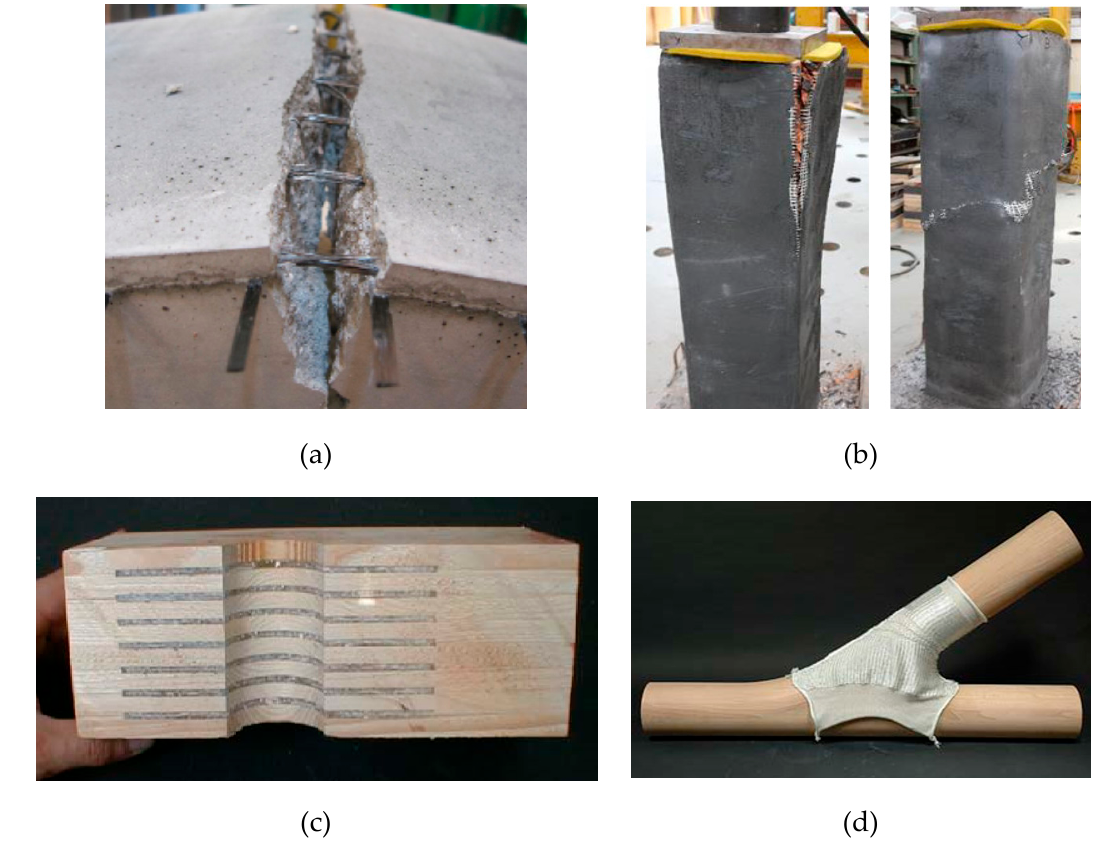
Figure 3. Examples of ( a ) textile reinforced concrete slab with carbon fiber mesh (reproduced from [39]), or ( b ) masonry column (reproduced from [40] with permission from Elsevier, license n. 4580730591053, May 2019), and ( c , d ) timber joints. ( c ): timber specimen with embedded knitted fabric reinforcement (cross-section; reproduced from [41]); ( d ) 3D knitted reinforcement for a solid connection (reproduced from [42] with permission from Springer Nature, license n. 4580731288540, May 2019).